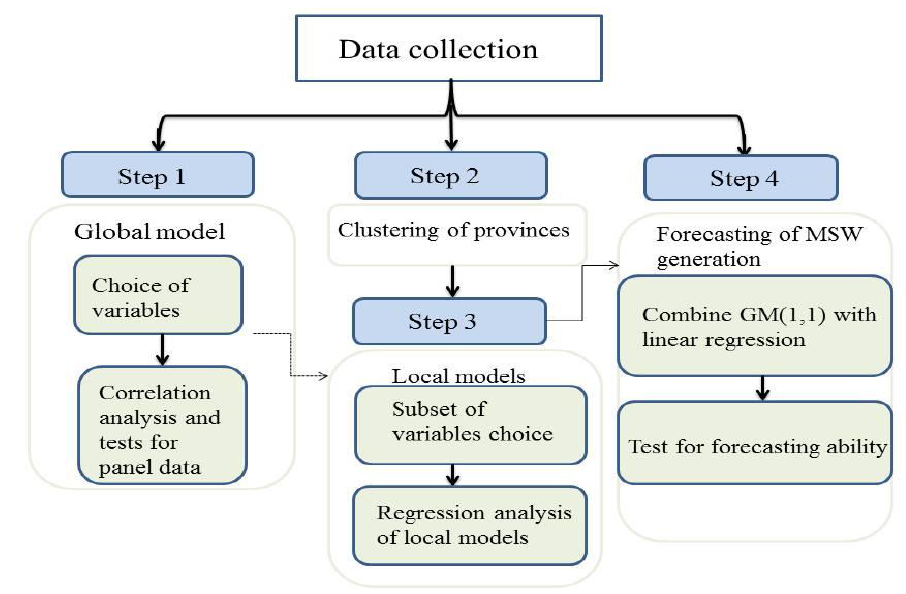
Figure 2. The flowchart for the methodology used in model building and forecasting of MSW generation.